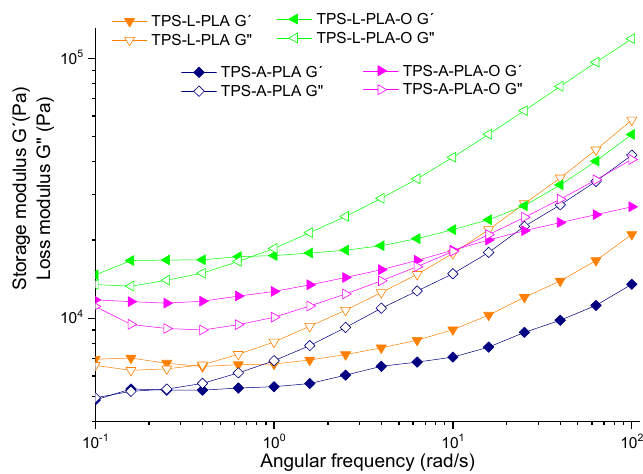
Figure 2. Dynamic rheological properties of TPS and PLA samples. The curves that show complex viscosity with respect to the angular frequency (Figure 3a) depend on the acid content in the different TPS and TPS/PLA samples. In gen- eral, lower values for acetic acid relative to lactic acid were shown in all samples analyzed. The incorporation of oleic acid in TPS/PLA samples increased the viscosity in a similar way to that when added to the TPS-L and TPS-A samples (~170 kPa). The TPS-L-PLA and TPS-A-PLA samples did not change from TPS (~70 kPa). Polymers became very thin as the shear increased, following a linear drop by two orders of magnitude. It should be mentioned that, in the range studied, no possible esterification or crosslinking reactions were shown, as had been observed for TPS samples. In this way, the curves obtained in the Cole–Cole diagram (Figure 3b) that relate the imaginary viscosity component ( η ”) to the real viscosity component ( η ’) increased the viscosity in TPS-A samples and shortened the relaxation times with respect to those of lactic acid. According to the previous results, it is possible to observe a smooth behavior in all samples. The absence of a multiphase system condition allowed the material’s mechanical properties to be predicted well.